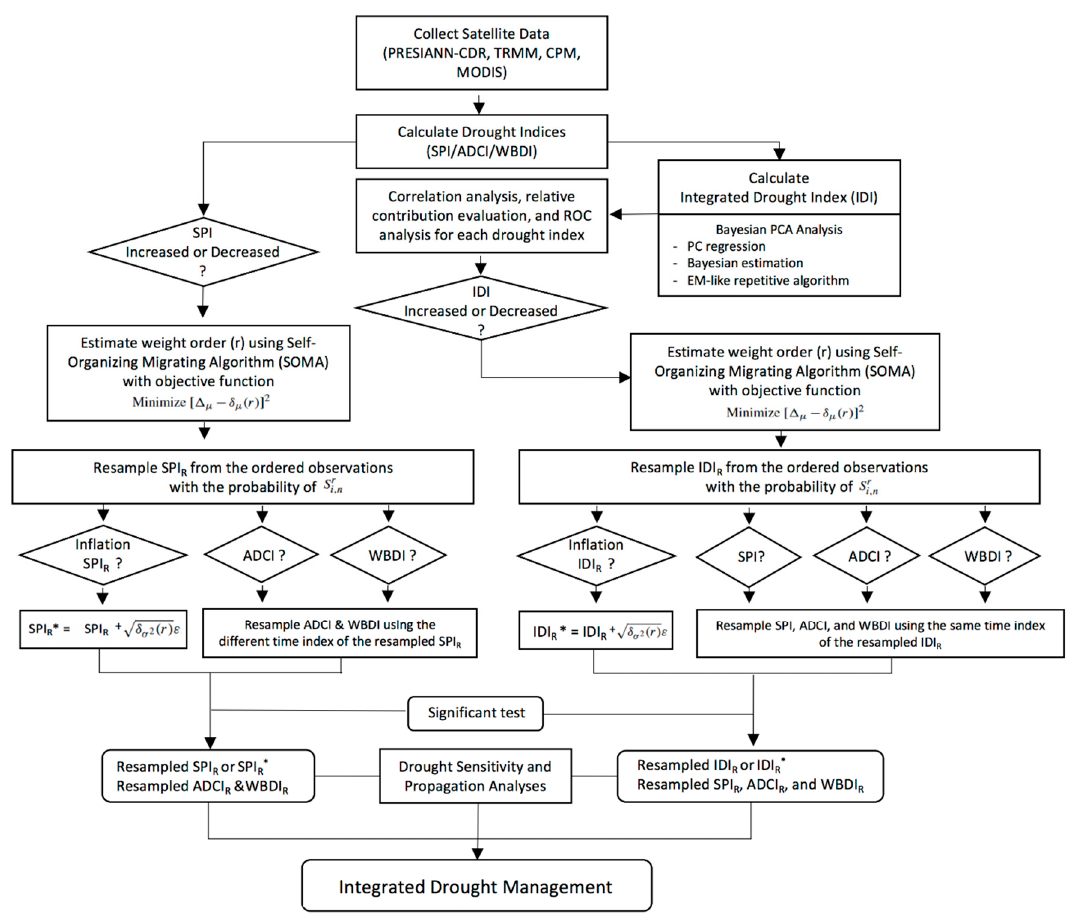
Figure 2. Procedure of intentionally biased bootstrap (IBB) analysis for integrated drought management.